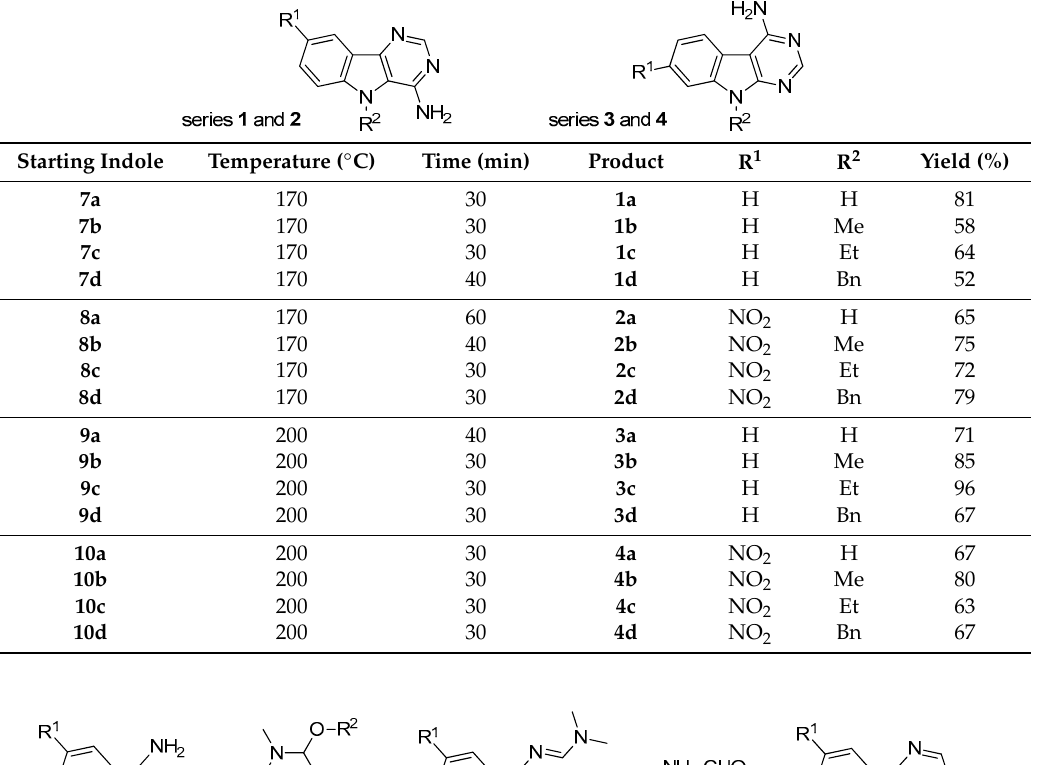
Table 1. Synthesis of series 1 , 2 , 3 , and 4 : temperature, reaction time, and isolated yields.